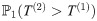
(a) Crossing valleys can be faster. Despite the red-dashed path containing a fitness valley (cells at vertex 2 have a reduced growth rate compared to the root population), the target population is more likely to arise via this path if λ − λ(2) < 1, as derived in (11). This is confirmed by the simulations displayed in (b), where λ − λ(2) = 0.8 < 1 and the Monte-Carlo estimate for P1(T(2)>T(1)) (the probability path 1 seeds the target first) is 0.58, while the analytic result yields 0.56. (b) Stochastic simulations of system in (a) vs theory (11). Parameters α = 0.9, β = 0.3, λ = 0.6, α(2) = 0.2, β(2) = 0.4, λ(2) = −0.2, ν = 0.1, runs = 250.